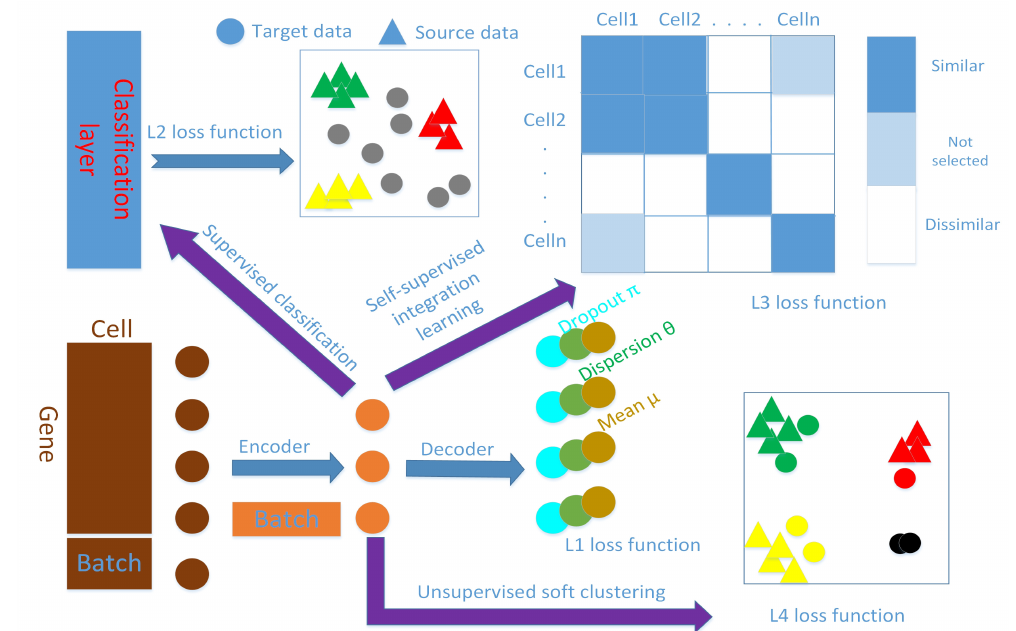
Figure 1. The neural network schematic diagram of scAnCluster. The encoder and decoder are symmetrical structures, and the outputs are three sets of parameters, including dropout rate, mean value and dispersion value, in zero-inflated negative binomial distribution (ZINB) modeling. We concatenate the batch index matrix in the input layer and bottleneck layer. In latent space, the mixed cells will enter three stages of learning in sequence: first the supervised classification learning of cells with known labels, second the self-supervised learning of dynamic similarity fusion of all cells, and third, the unsupervised soft clustering learning of all